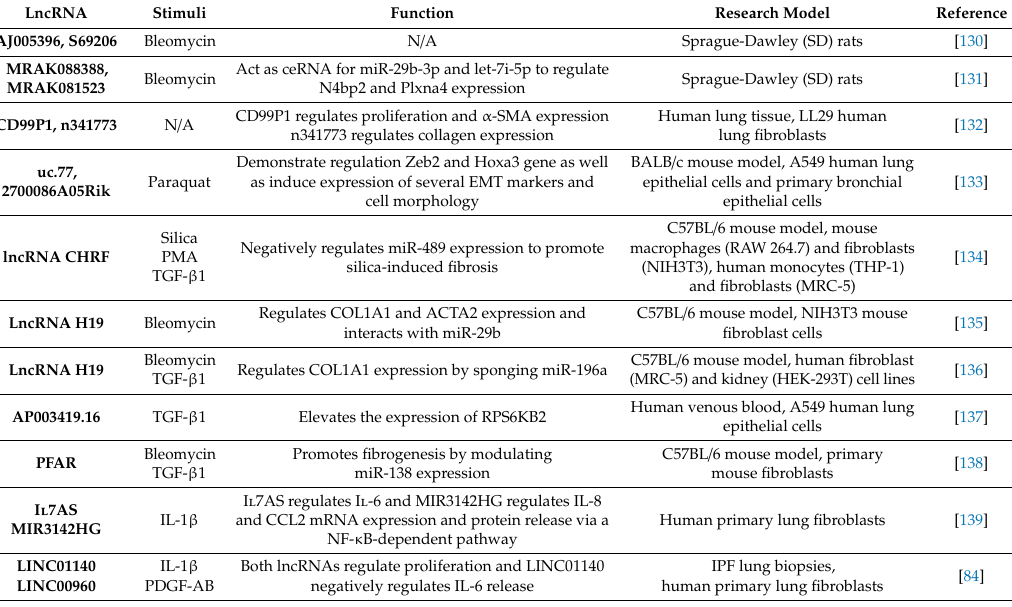
Table 1. LncRNAs associated with pulmonary